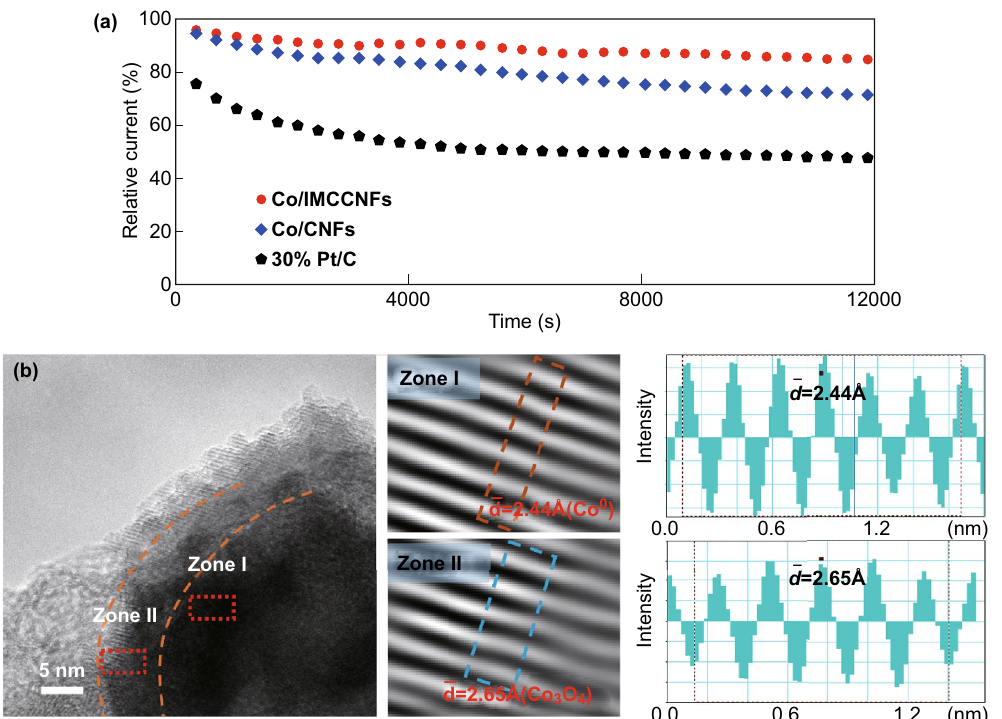
Fig. 5 a I – t curves of 30% Pt/C, Co/IMCCNFs, and Co/CNFs. b High-resolution TEM images of the Co/IMCCNFs after the I – t test (the middle images show the lattice fringes, while the right patterns reveal the lattice